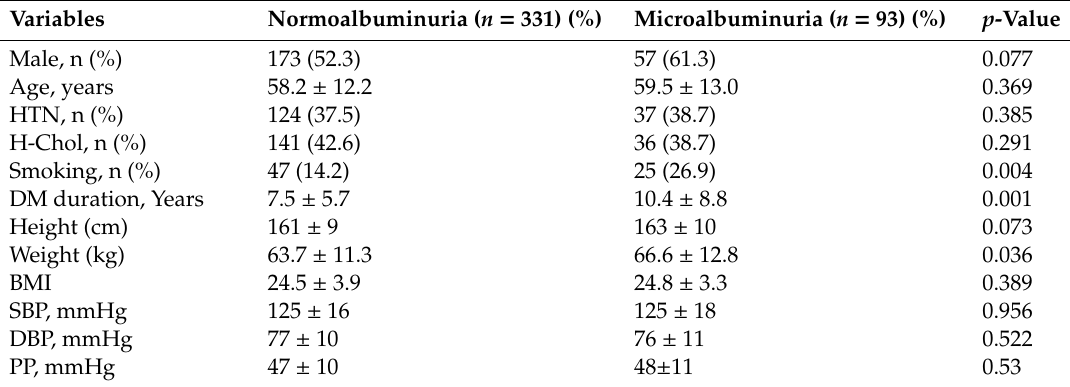
Table 1. Baseline clinical characteristics of the study subjects.